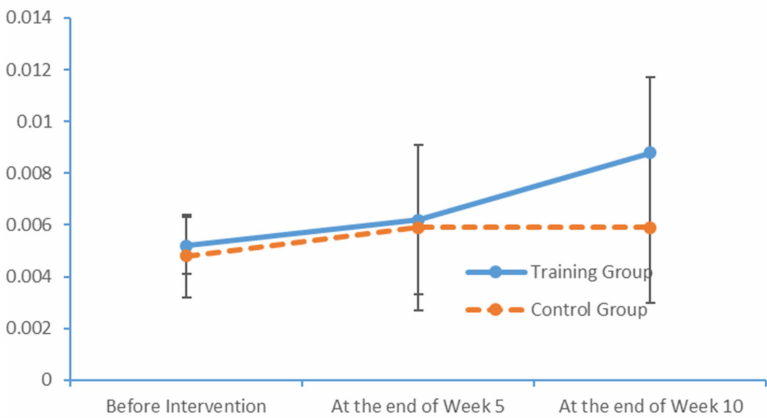
Figure 9. Changes in the power values of the alpha_hemi_left wavebands measured in the two subject groups at several time